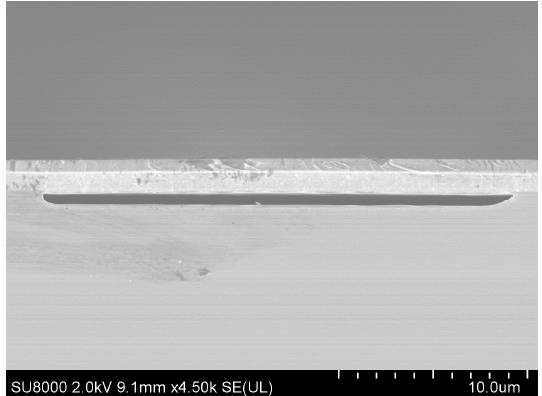
Figure 4. A micromachined cavity with bulk 4H-SiC at the bottom and polycrystalline SiC on top.